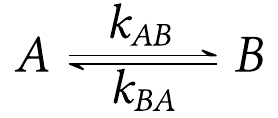
Figure 1. Spin kinetics of two-state